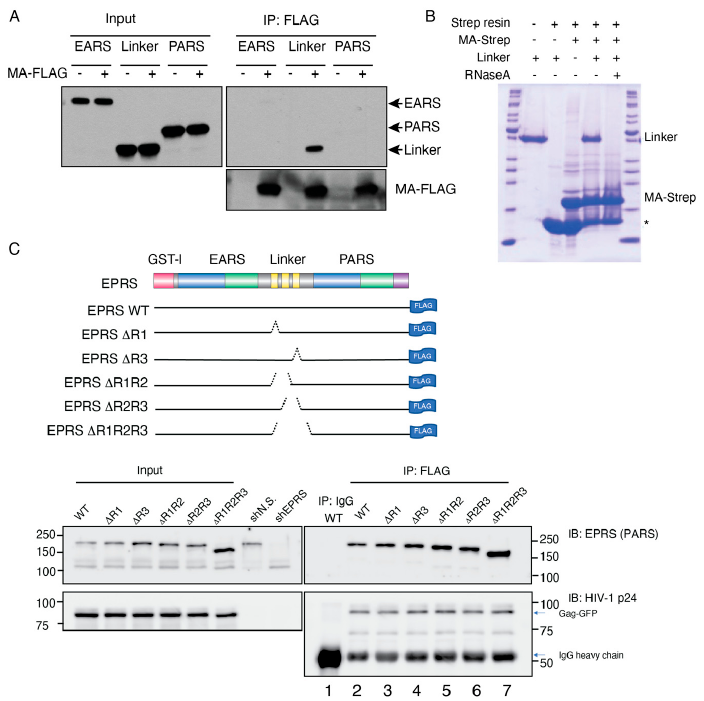
Figure 3. Domain mapping of MA–EPRS interaction. ( A ) Individual domains of EPRS (EARS, linker, and PARS) were co-expressed with MA-FLAG and subjected to co-immunoprecipitation with FLAG antibody. ( B ) Bacterially expressed EPRS linker and MA-strep protein were incubated with strep beads with or without RNaseA treatment. The proteins bound to the beads were resolved on an SDS-PAGE gel and visualized by Coomassie staining. Band with asterisk (*) indicates streptavidin monomer eluted from the strep affinity resin. ( C ) Top: schematic of WT EPRS and truncated Δ linker constructs. One, two, or all three WHEP domains (yellow bars in the linker region) were truncated. Bottom: co-IP of HIV-1 Gag-GFP with EPRS-FLAG (full-length WT or with WHEP domain trunca- tions, as indicated). EPRS-FLAG constructs were co-expressed with Gag-GFP in an EPRS knock- down background. 3.3. The Linker Domain of EPRS Interacts Promiscuously with tRNAs While RNA is required for HIV-1 MA interaction with EPRS (Figure 3B), whether a specific RNA species mediates the interaction is unclear. A crosslinking-IP sequencing study showed that tRNAs are the most frequent Gag-bound RNAs in cells and that the MA is domain bound almost exclusively to tRNAs [30]. Given that tRNAs are the native substrates of ARSs and are presumably enriched near the MSC, we hypothesized that the MA–EPRS interaction is mediated by tRNAs. To test this hypothesis, we first investigated the tRNA binding properties of the EPRS linker using purified recombinant linker-de- rived proteins and four in vitro transcribed, 3 ′ fluorescently labeled tRNAs. We tested binding to human tRNA Lys3 , the primer for HIV-1 reverse transcription, human tRNA Glu , and tRNA Pro , the substrates of EPRS, and bovine tRNA Trp as an unrelated control. EPRS linker proteins were titrated into 5 nM of each tRNA, and the dissociation constant, K d , was derived from fluorescence quenching curves (Figure 4). The full-length EPRS linker